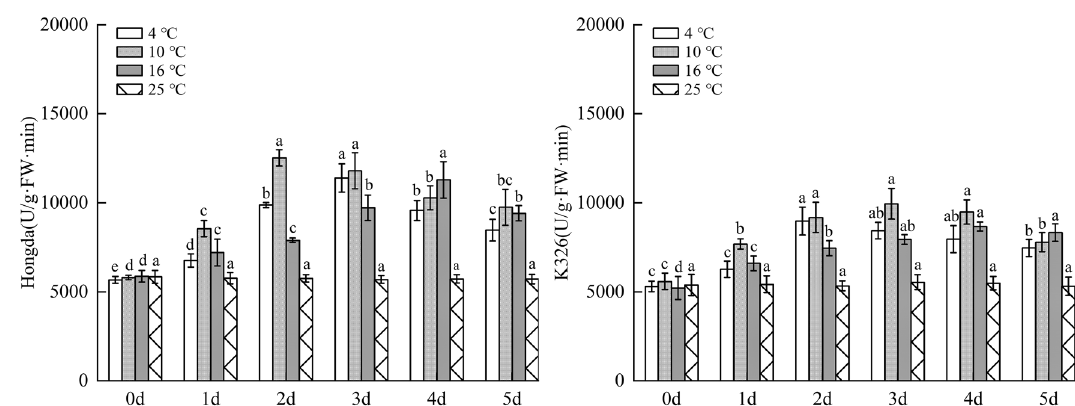
Figure 11. The changes of POD activity in tobacco leaves under different low-temperature stresses. Different lowercase letters indicated that there were significant differences at different times under the same temperature treatment (P < 0.05). The values were the mean of three biological